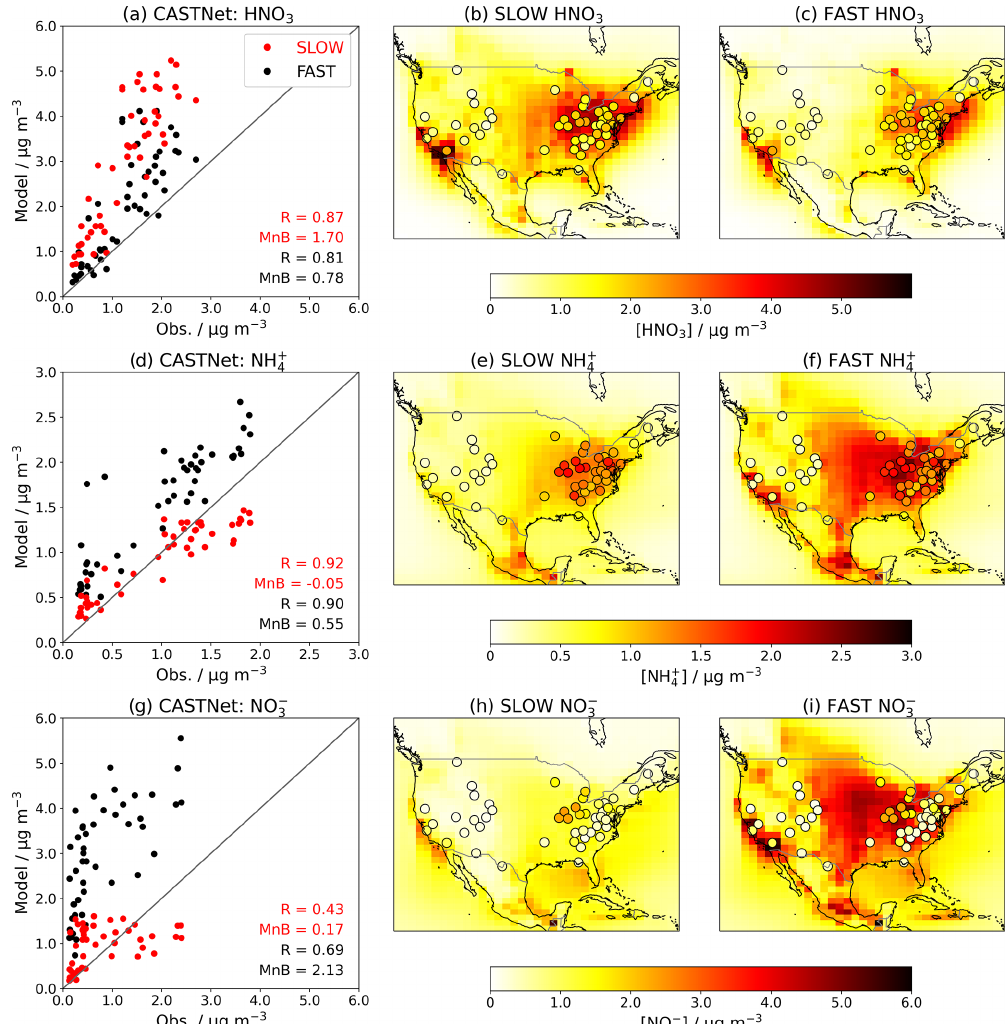
Figure 5. Annual-mean HNO 3 , NH 4 , and total-NO 3 near-surface concentrations in the FAST and SLOW simulations over North America compared to CASTNet observations averaged over 1994–2013. In panels (b, c, e, f, h, i) , coloured contours show simulated concentrations while overlaid filled circles represent CASTNet observations. In panels (a, d, g) , “R” is the Pearson’s correlation coefficient, and “MnB” is the mean bias between simulated and observed